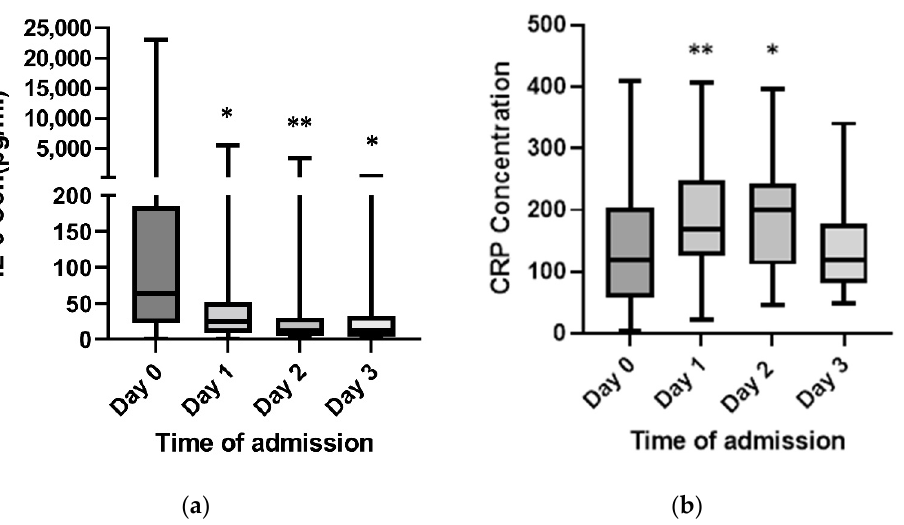
Figure 2. Plasma levels of IL-6 and CRP in E. coli - and K. pneumoniae -infected patients. Plasma samples were collected on days 0, 1, 2, and 3. Plasma IL-6 ( a ) and CRP ( b ) levels on days 1, 2, and 3 in patients are compared with the day 0 results. Results are expressed as the median with the interquartile range (box plot) with the maximum and minimum value (whiskers plot). Two-tailed paired Mann–Whitney tests were performed. ** p < 0.01 vs. day 0; * p < 0.05 vs. day 0.